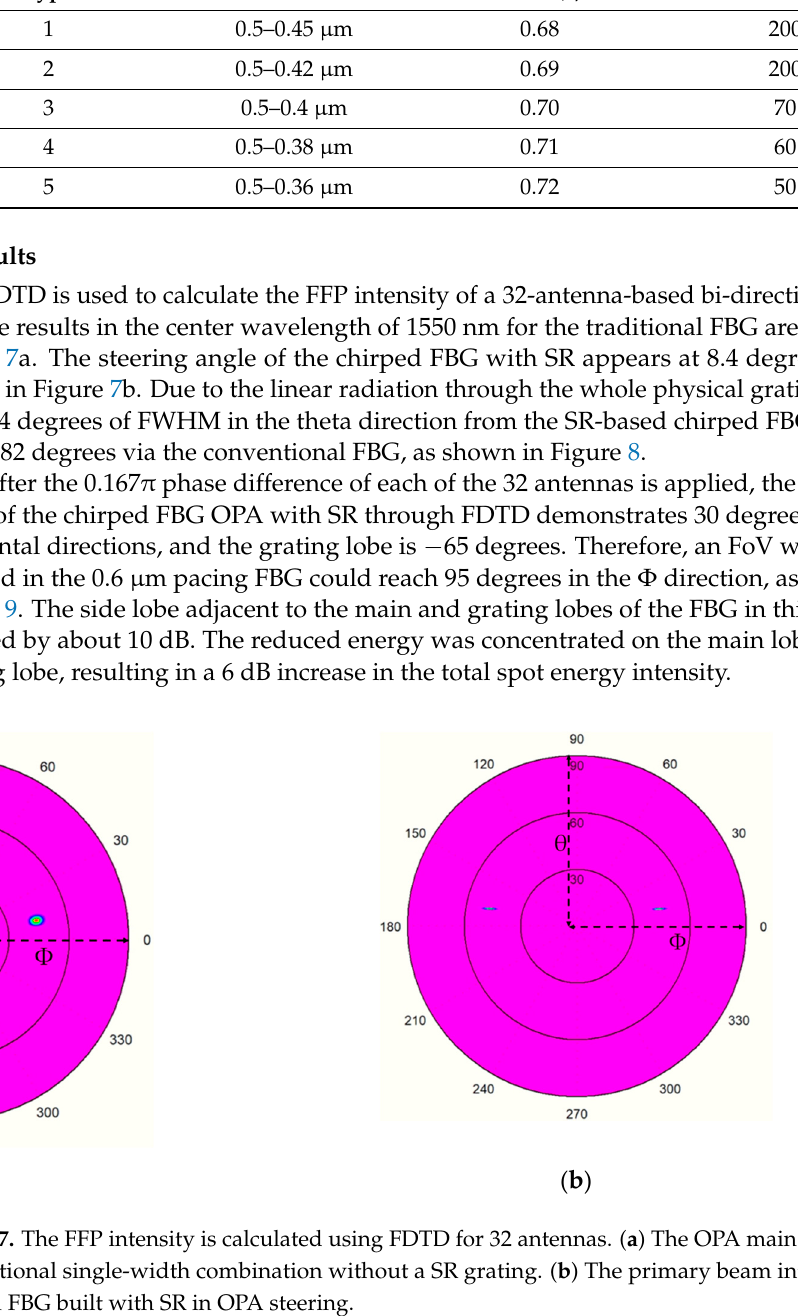
Figure 8. θ -directional strength is compared between SR-based linear attenuation (red line) with the chirped FBG and conventional antennas (blue line).